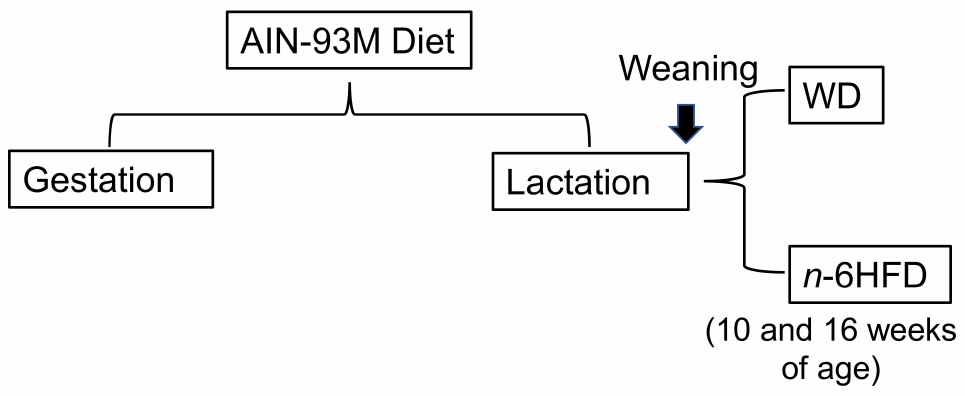
Figure 12. Experimental design and mouse animal model. C57BL/J6 dams were fed a purified diet AIN-93 through gestation and lactation. At weaning, male mice were assigned to either a Western diet (WD) or an n -6 high-fat diet ( n -6HFD) through 10–16 weeks of age. The WD and n -6HFD were formulated to be isocaloric (kcal/g) by adjusting the percentage of carbohydrates (corn starch) and fiber (cellulose), whereas the percentage of protein, sugar, vitamins, and minerals remained unchanged between the two diets (Tables 2 and